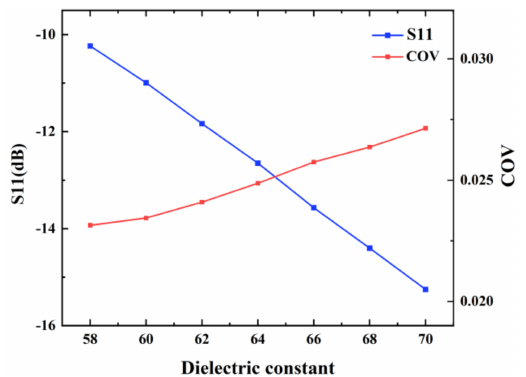
Figure 11. S11 and COV values of the microwave continuous-flow system for different dielectric constants of the liquid.